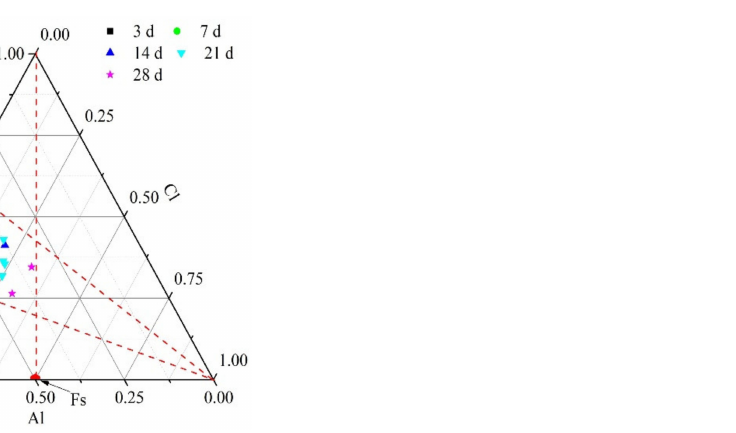
Figure 10. Equivalent ternary diagram of Al, S, and Cl elements in the hydration products of SG2 at 3, 7, 14, 21, and 28